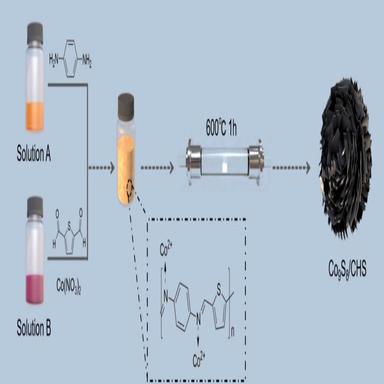
Schematic illustration of the preparation procedure of Co9S8/CHS.